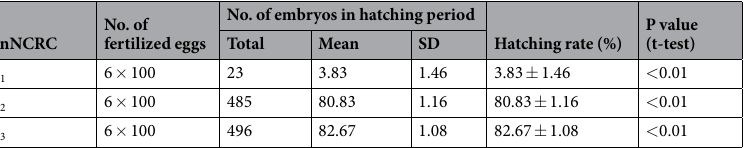
Table 2. Average survival ratios of early generations of 2nNCRC embryos from 2nCOC ( ♀ ) x 2nBSB ( ♂ ). SD: Standard deviation. Hatching rate = number of surviving embryos at the stage of hatching/number of fertilized eggs × 100%. Embryonic development was observed at a water temperature of 22 °C using a Meiji RZ Stereo microscope. One hundred fertilized eggs selected at random from each group were examined, and six replicates of each fish were included. The criteria for evaluating the early embryonic development of 2nNCRC were described by Liu